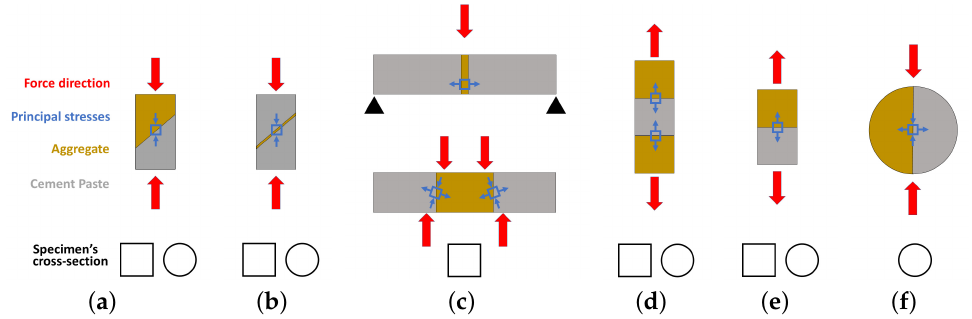
Figure 2. Group 2: Typical tests to investigate the mechanical behavior between aggregate and cement- based matrices: ( a , b ) slant shear—adapted from [17], ( c ) flexural (top) and shear (bottom)—adapted from [25]), ( d , e ) direct tensile, and ( f ) indirect tensile—adapted from [19]) apud [18]).